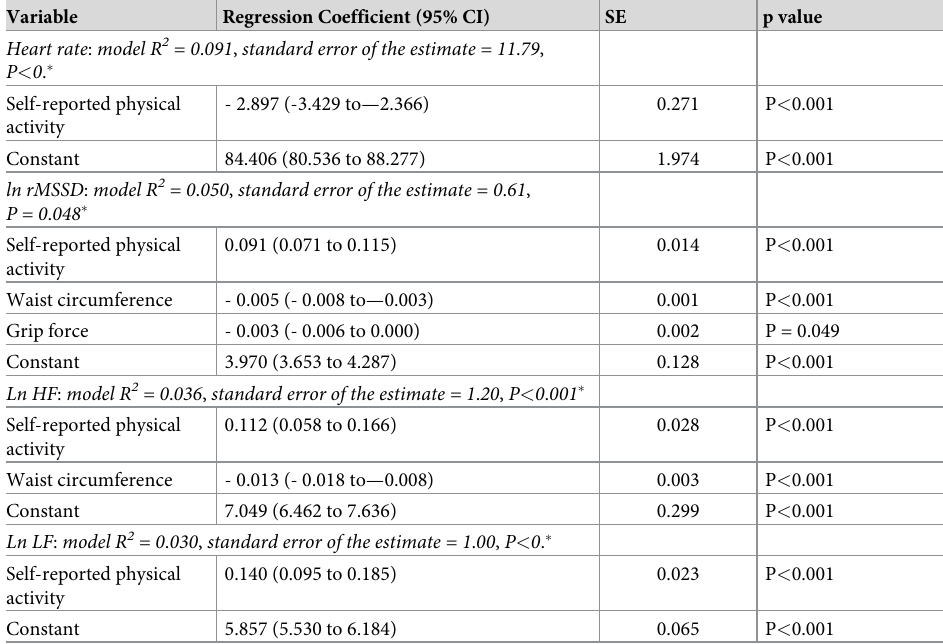
Table 3. Significant predictors of HRV indices and HR in multivariable linear regression analysis concerning ado- lescent men (n =